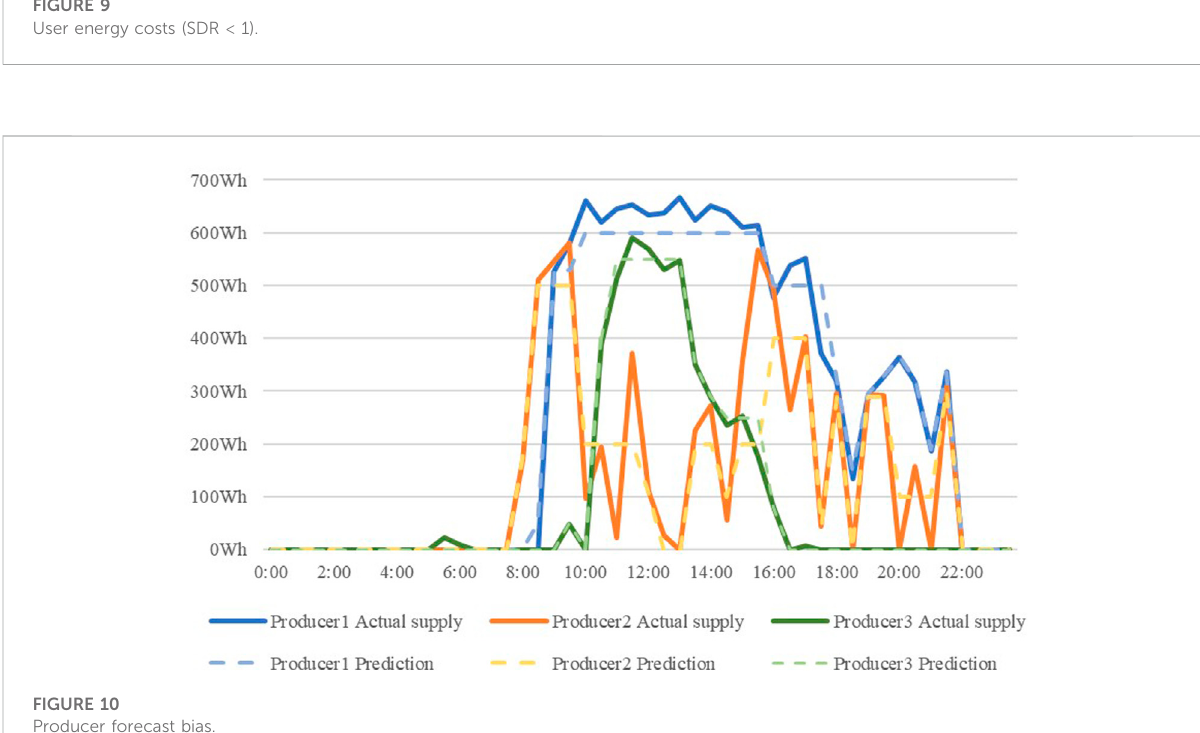
FIGURE 10 Producer forecast